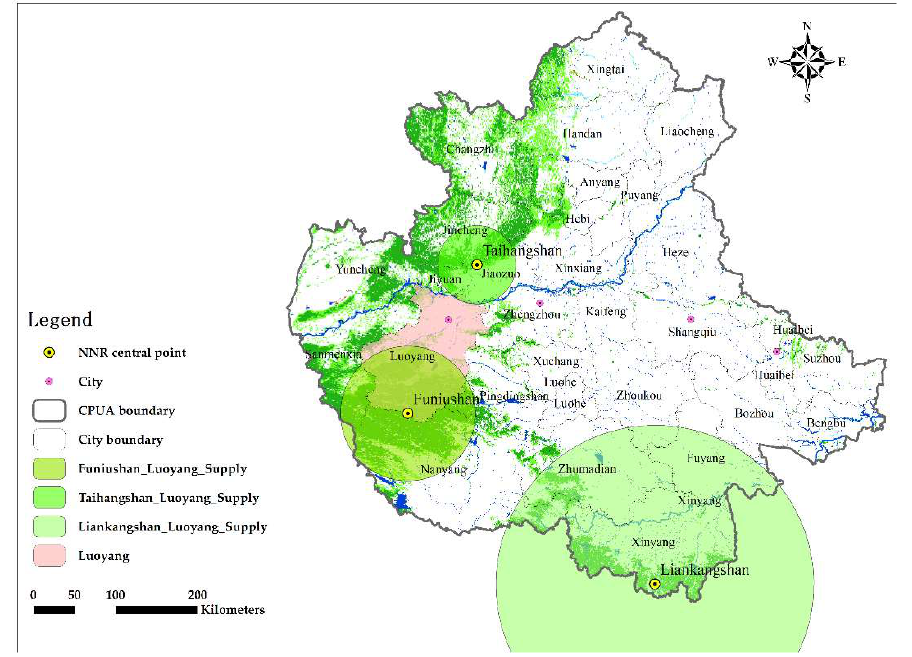
Figure 7. Integrated ES supplies of ecospace ES to Luoyang.